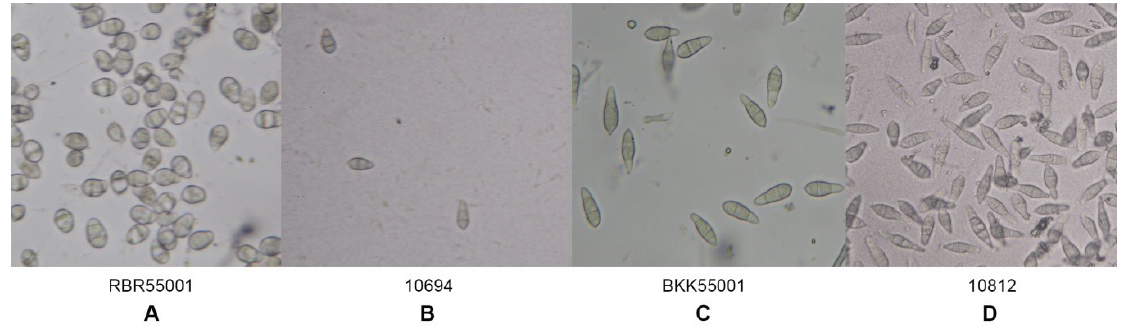
Figure 3. Variation in conidia morphology shape under a light microscope. A: Pattern A, oval conidia; B: Pattern B, short pyriform conidia; C: Pattern C, pyriform conidia; and D: Pattern D, long pyriform conidia.